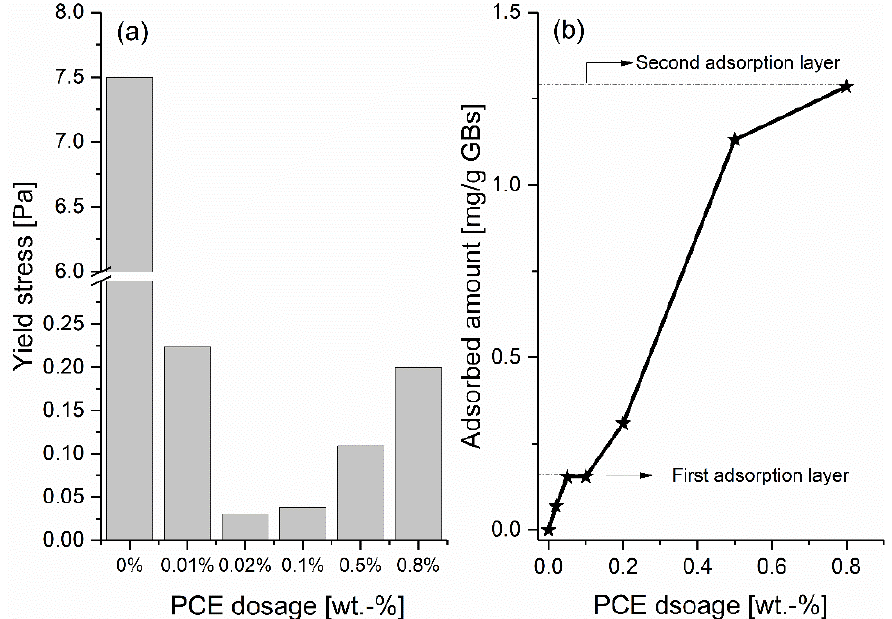
Figure 2. Yield stress of GBS ( a ) [18] and the adsorbed amount of PCE ( b ) along with the increasing PCE dosages.